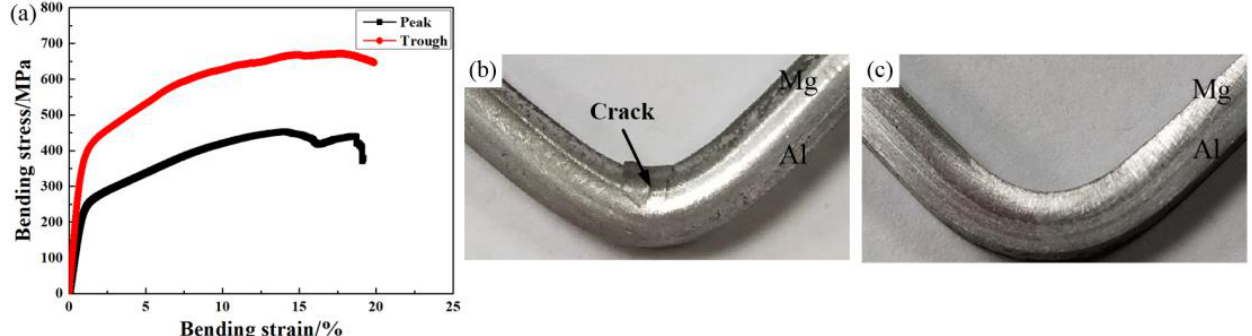
Figure 12. Transverse bending properties of the corrugated clad sheet: ( a ) bending stress–strain curves; ( b ) peak morphology after bending; ( c ) trough morphology after bending.